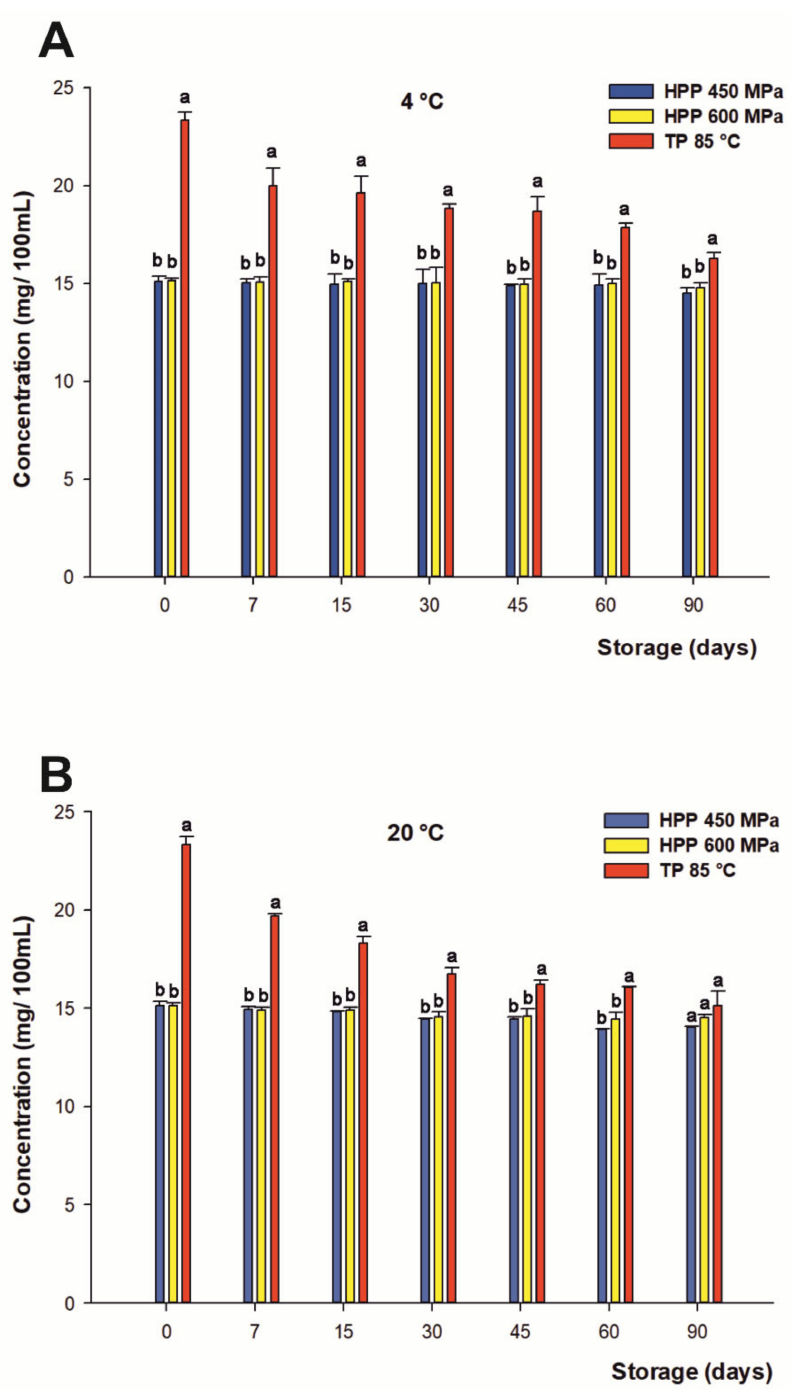
Figure 2. Changes of content in the total flavanones (mg/100 mL) of juices subjected to high hydrostatic pressure (HHP— 450 and HHP —600 MPa) and thermal pasteurization (TP— 85 ◦ C), measured during storage for 90 days in refrigerated conditions at 4 ◦ C ( A ) and 20 ◦ C ( B ) under darkness conditions. Bars with different lowercase letters within each time point were different statistically at p < 0.05 according with the analysis of variance (ANOVA) and Tukey’s multiple range